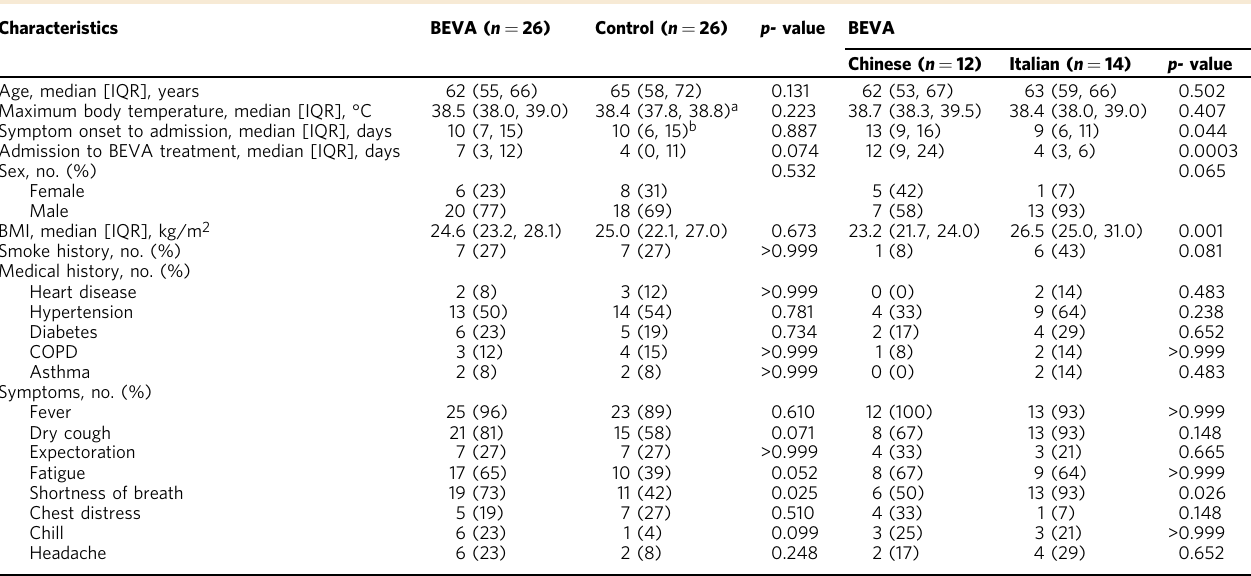
Table 1 Baseline demographic and clinical characteristics of the patients.